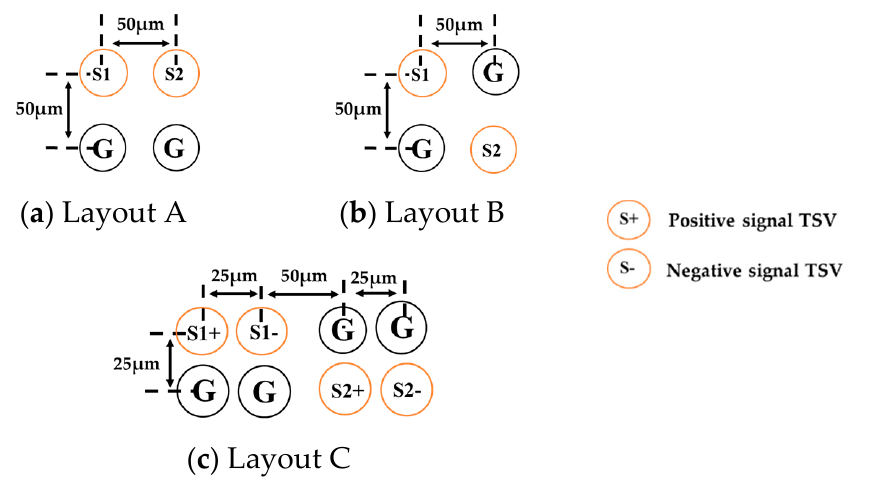
Figure 4. Three Layouts of TSV array: ( a ) TSV array side by side, ( b ) Staggered TSV array, ( c ) A pair of differential signal TSVs instead of a single-ended signal TSV staggered array (same silicon area of TSV array) .